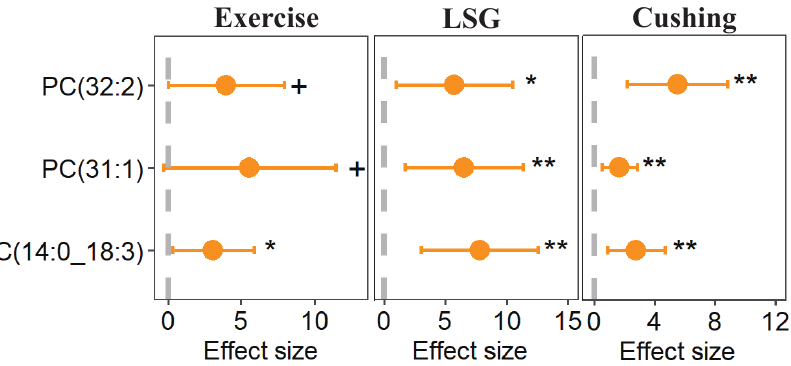
Figure 8. Potential biomarkers of weight loss. Values calculated by linear regression analysis after logarithmic transformation of lipid data, + p < 0.1, * p ≤ 0.05, ** p ≤